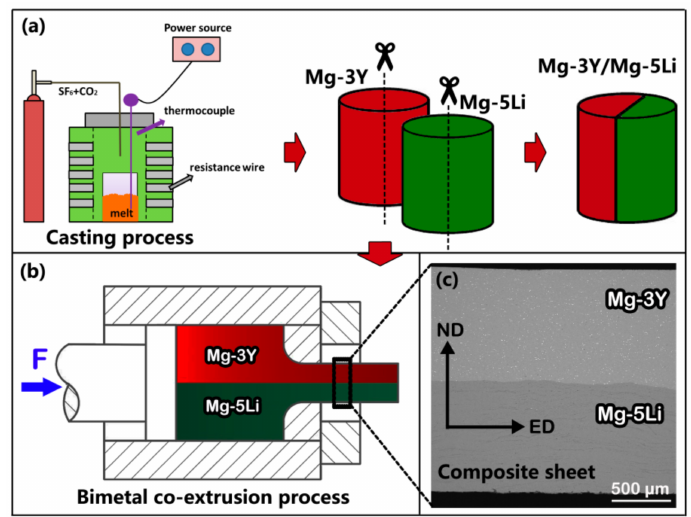
Figure 1. ( a ) Preparation of cast Mg-3Y/Mg-5Li (W3/L5) composite billet; ( b ) bimetal co-extrusion process; ( c ) SEM image of W3/L5 laminated composite, where ND and ED represent the normal and extrusion directions, respectively.